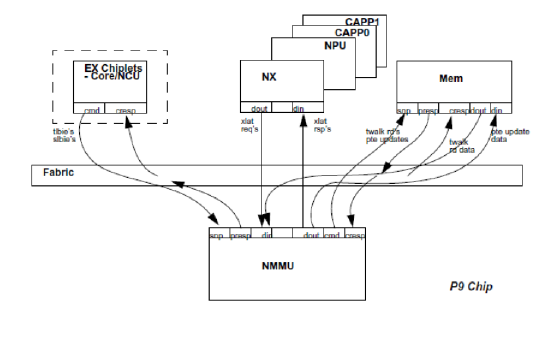
Figure 1. Nest Memory Management